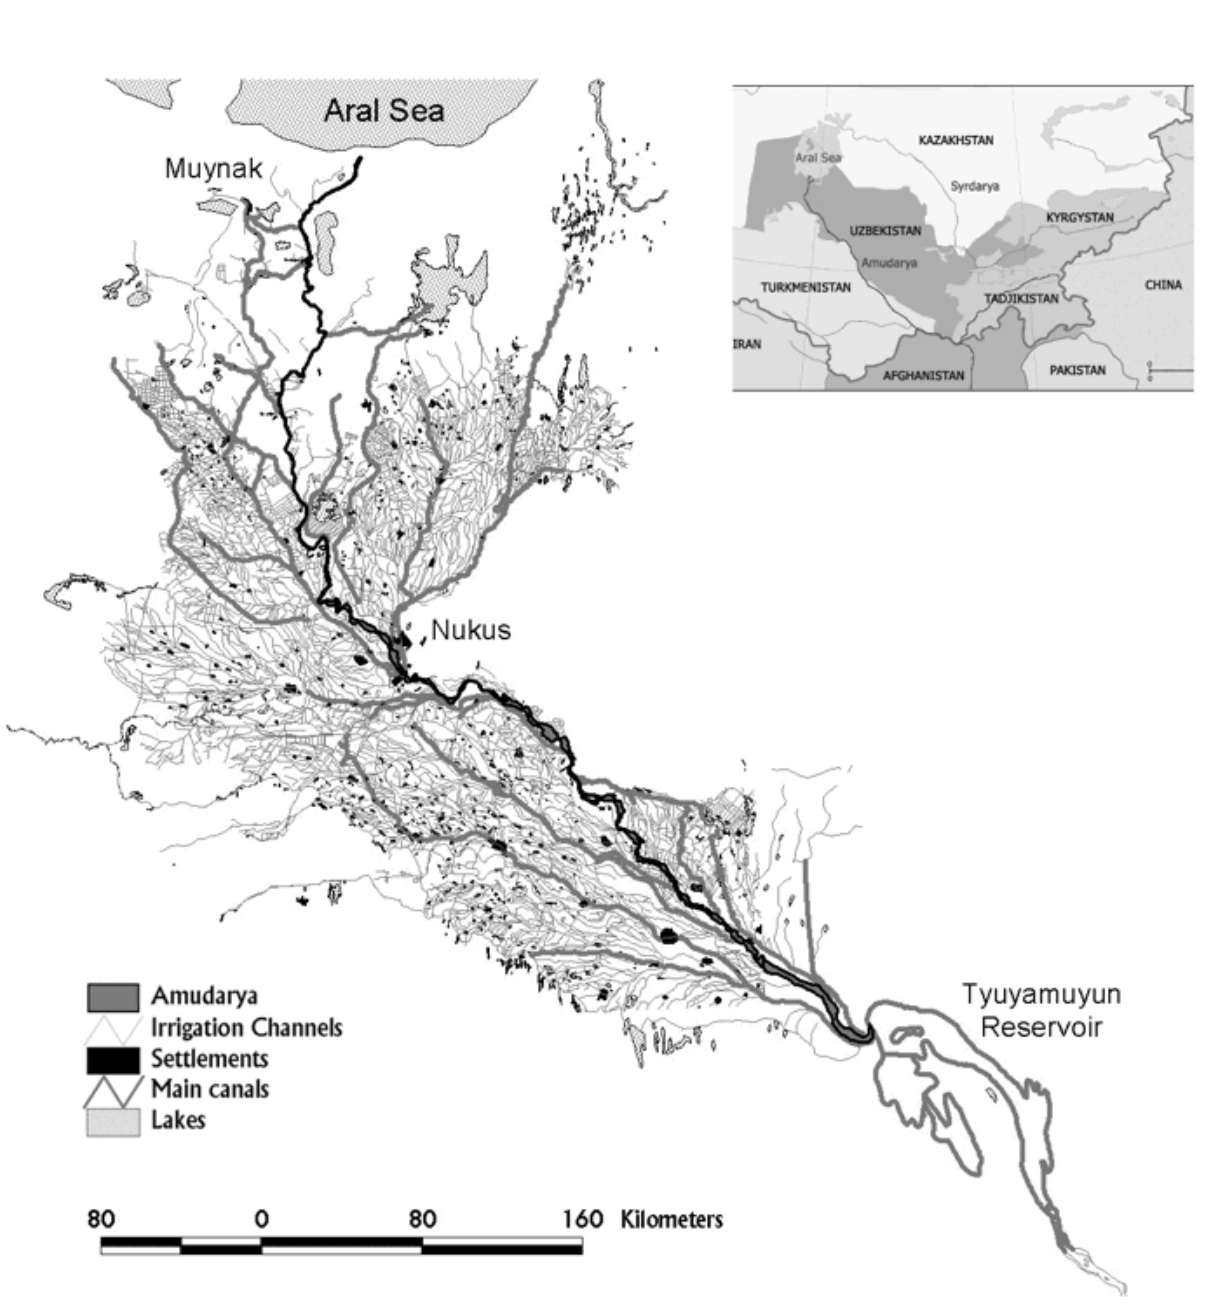
Fig. 1. Map of the Amudarya River delta in Central Asia. The delta is located in the Republic of Uzbekistan, Turkmenistan, and the Autonomous Republic of Karakalpakstan (Uzbekistan). Water distribution in the delta region is largely determined by the Tyuyamuyun system of single-year reservoirs at the entrance to the delta. Water is diverted into a vast network of irrigation and drainage canals. The lakes in the northern part of the delta are intensively used for fishing. Source: modified from Aral Sea GIS (Micklin et al.